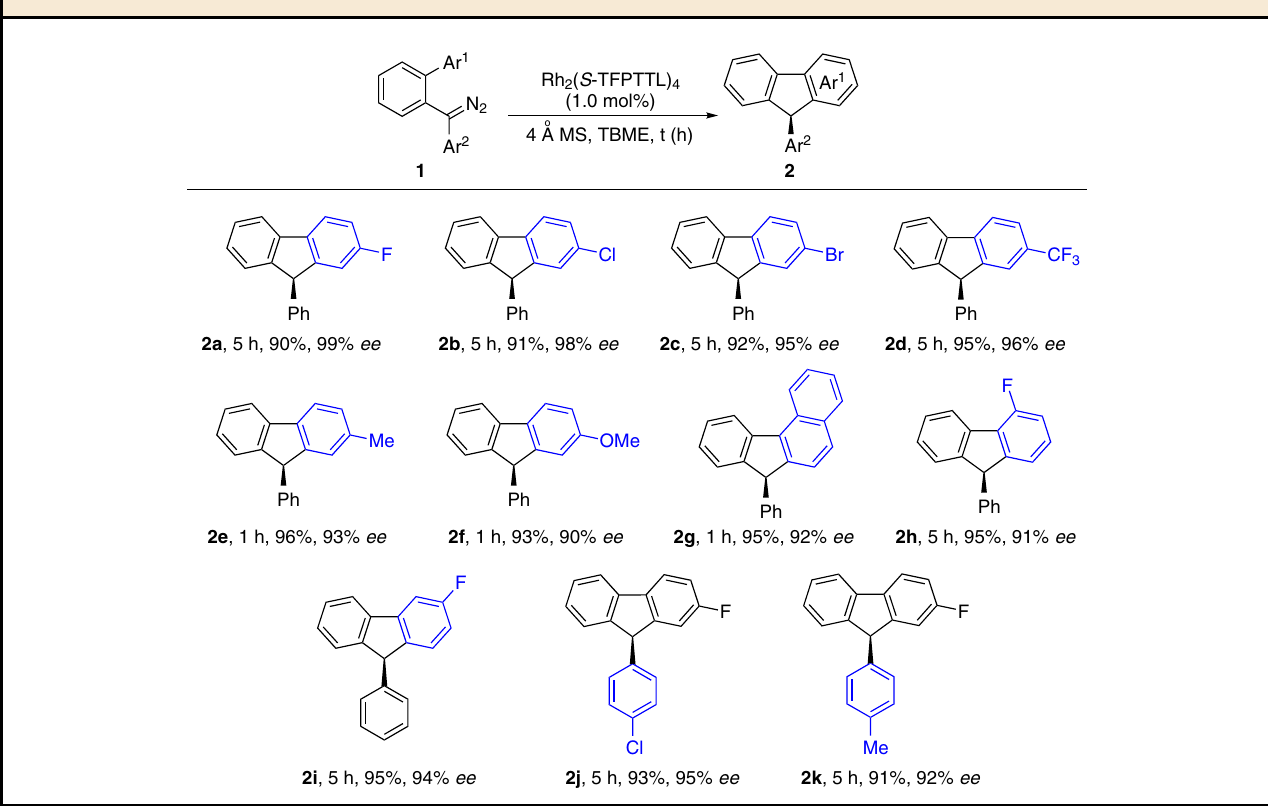
Table. 2 Substrates scope of direct asymmetric C – H functionalization a